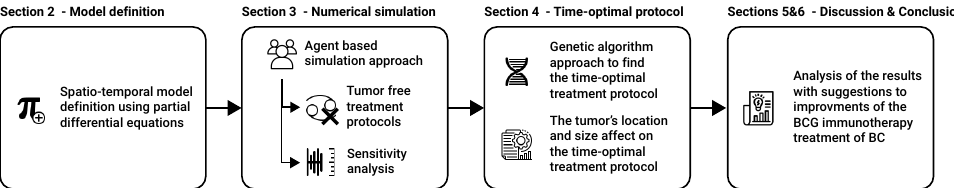
Figure 1. The manuscript’s structure. First, we introduce our novel cell-level spatio-temporal model. Afterward, an agent-based simulation approach is proposed to numerically solve the model, and the tumor-free treatment protocol based on the current standard treatment protocols is evaluated, in addition to the sensitivity of the treatment’s performance to changes in its parameters. Next, a genetic-algorithm-based approach to finding a time-optimal treatment protocol is described and used to explore the feasibility of a BCG-based treatment of different initial conditions. Finally, an analysis of the results and closing remarks are